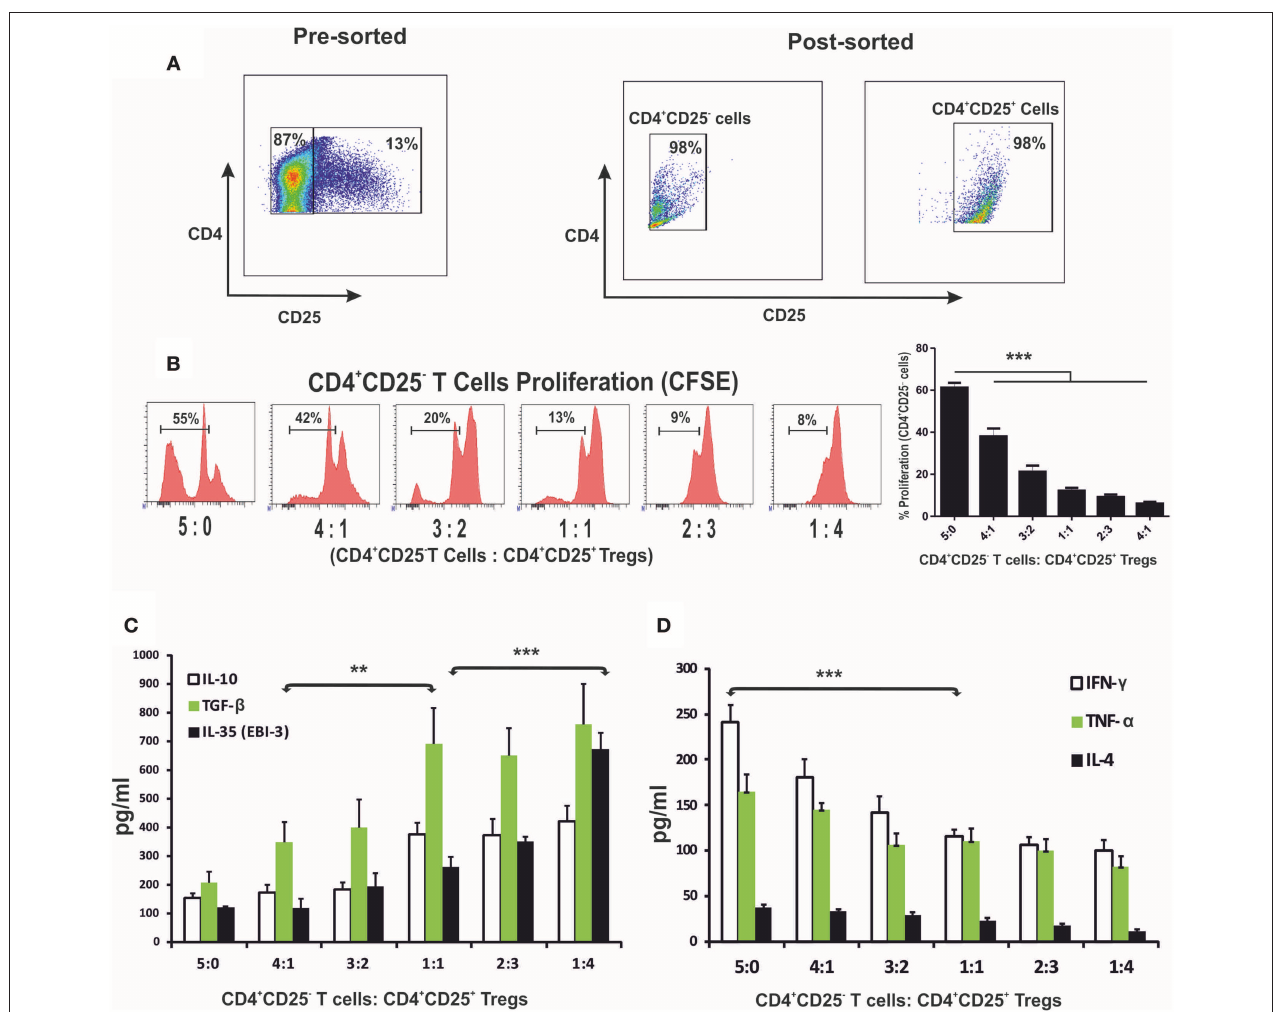
FIGURE 3 | CD4 + CD25 + T cells suppressed protective immune response when co-cultured with CD4 + CD25 − T cells. Splenic CD4 + CD25 − T cells (labeled with CFSE) and CD4 + CD25 + T cells, were enriched through magnetic sorting from 4 months infected mice (A) , were stimulated with anti-CD3 and anti-CD28 and co-cultured in 96U bottom plate at various indicated ratios. After 96h cells were collected for CFSE based CD4 + CD25 − proliferation assay through flow cytometry. Histograms and graph show percent proliferation of CD4 + CD25 − cells co-cultured with CD4 + CD25 + T at various ratios (B) . Supernatants of the co-culture were used for cytokine profiling (C,D) . Data expressed as means ± SE for at least five mice per group are representative of three independent experiments with similar results. ** P < 0.01; *** P < 0.001 as assessed by one-way ANOVA and Tukey’s multiple comparison